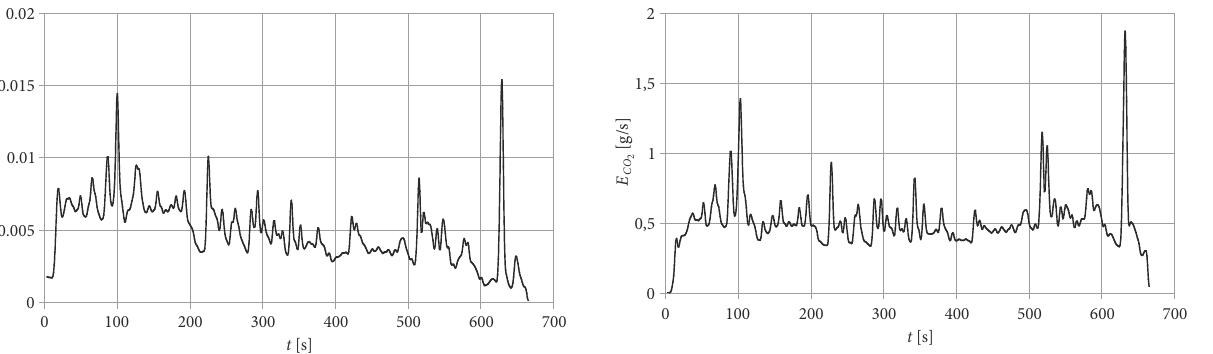
Figure 14. Time history of the carbon dioxide emission intensity E CO in the CT1 2